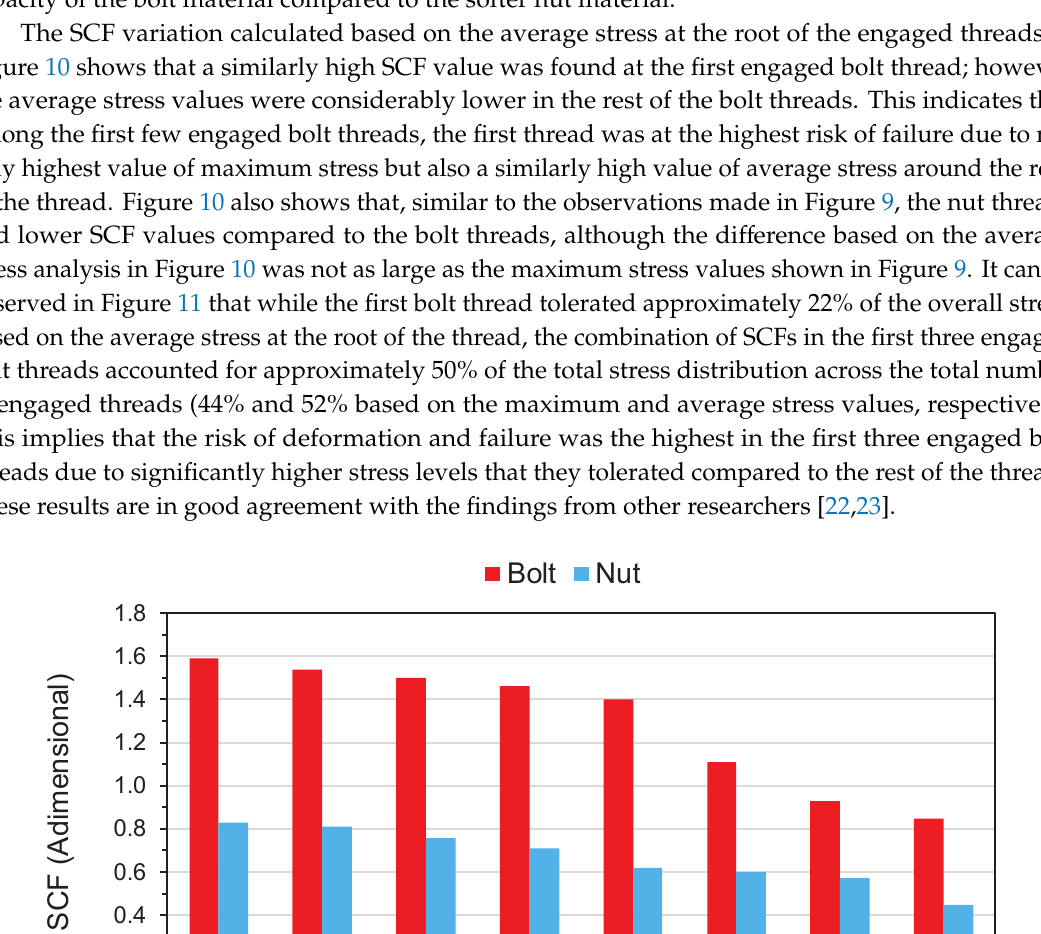
Figure 8. Stress concentration factor (SCF) analysis at the root of the threads in the bolt (red lines) and the nut (blue lines) .